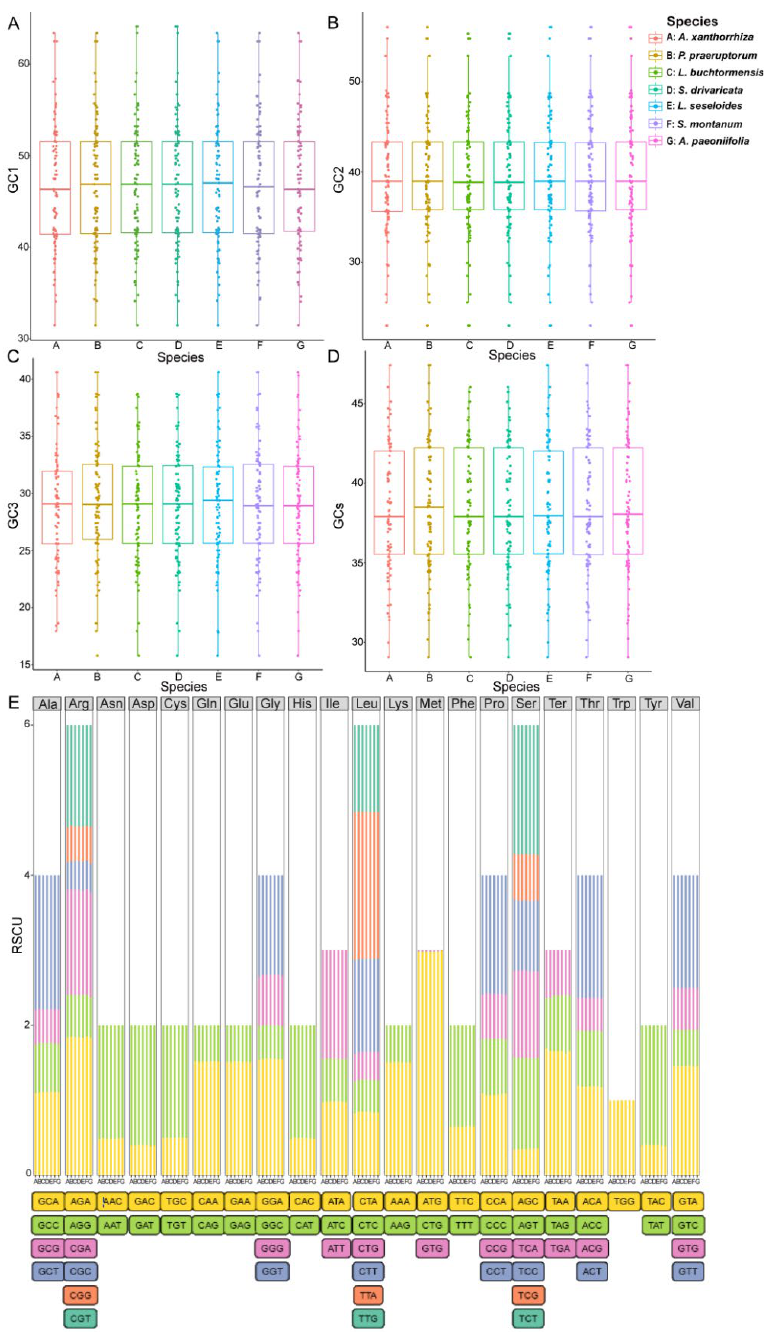
Figure 3. Comparison of the GC content, codon usage preference, and amino acid proportion in the protein-coding genes of seven chloroplast genomes. ( A – D ) GC content in the synonymous codons at the first (GC1), second (GC2), and third (GC3) positions and total GC content (GCs). ( E ) Codon preference and proportion of amino acids based on relative synonymous codon usage (RSCU) values. Ter represents the stop codon. Legend: A, A. xanthorrhiza ; B, P. praeruptorum ; C, L. buchtormensis ; D, S. divaricata ; E, L. seseloides ; F, S. montanum ; G, A. paeoniifolia .